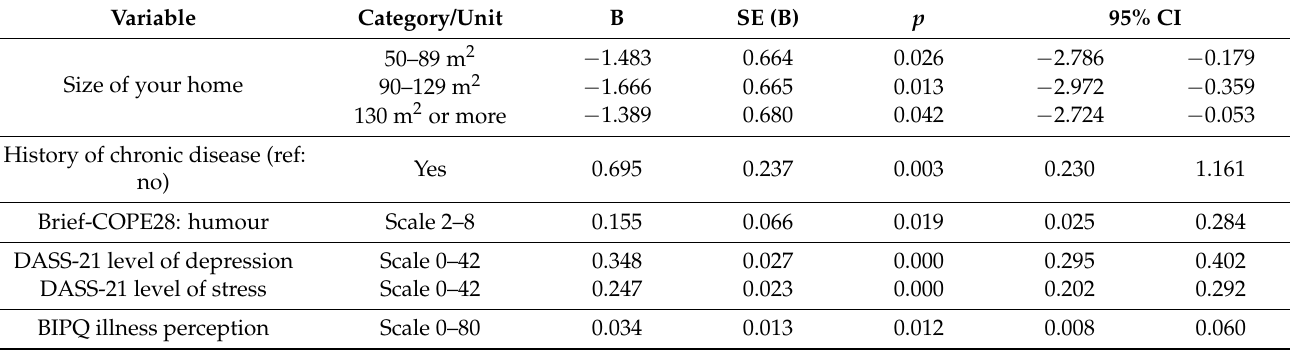
Table 4. Factors related to anxiety scores: linear regression model.